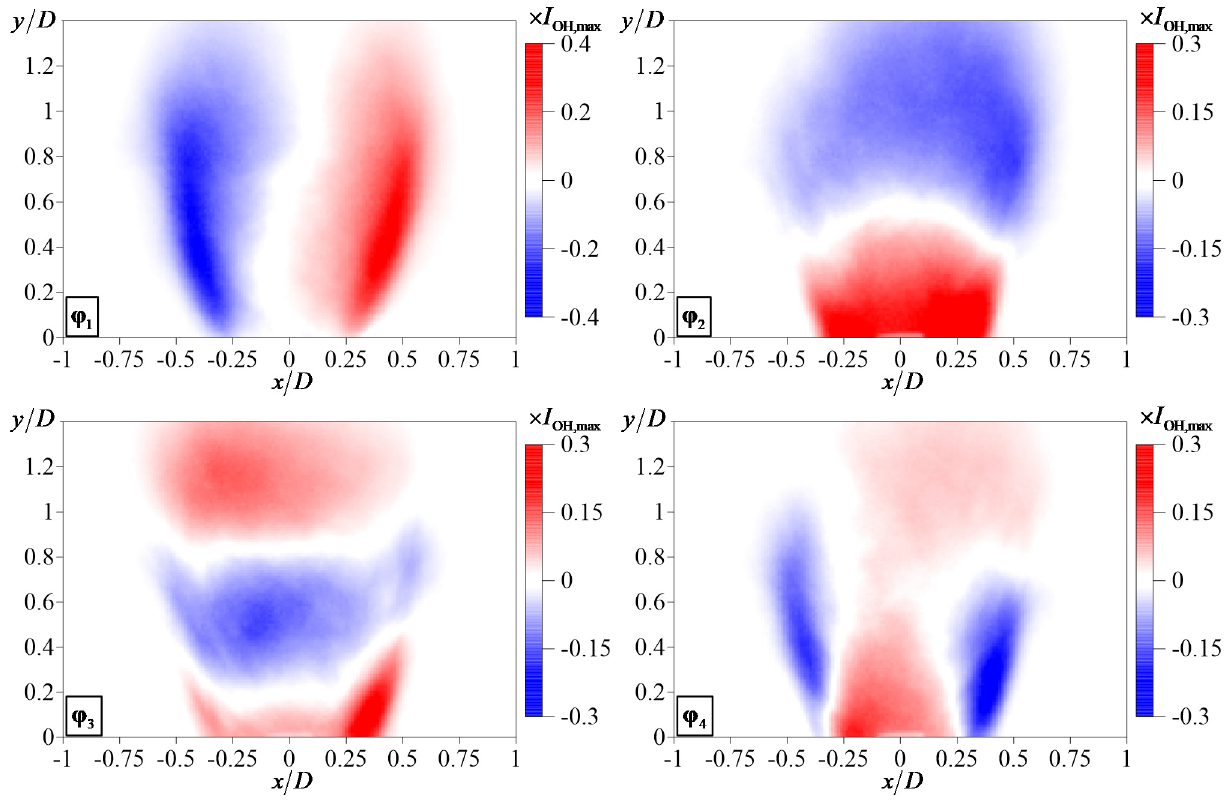
Figure 16. Four first PCA modes of OH* chemiluminescence images for methane flame at elevated conditions.